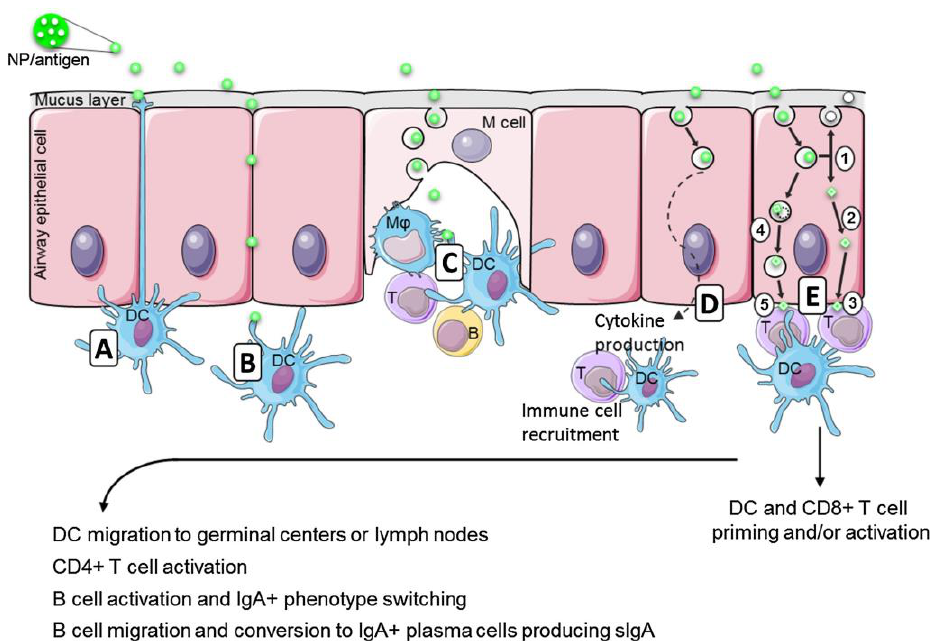
Figure 2. Mucosal immune induction in nasal and airways epithelia by antigen-loaded nanocarriers (NP/antigen). ( A ) Dendritic cells (DC) protruding arms, the transepithelial dendrites, directly capture the NP/antigen. ( B ) NP/antigen can also diffuse through epithelial junctions and reach the underlying DC. ( C ) The M cells create a pocket enriched in immune cells (DC, macrophages-Mφ and lymphocytes T) and perform the sampling of the luminal antigens so that the immune cells contact the NP/antigen. ( D ) The NP/antigen can also enter cells by endocytosis and deliver the antigens of the nanovaccine